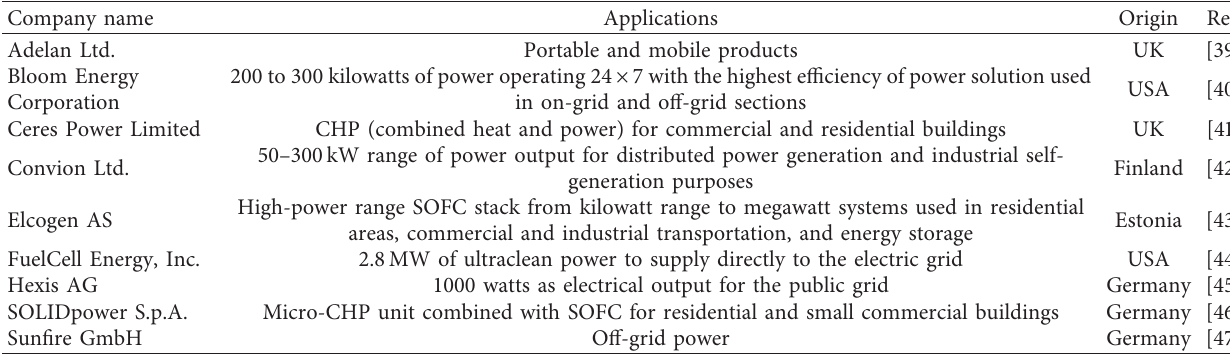
Figure 2: Power supply systems based on solid oxide fuel cells from the main building of the hospital to the temporary hospital extensions [24]. Table 1: List of SOFC companies with